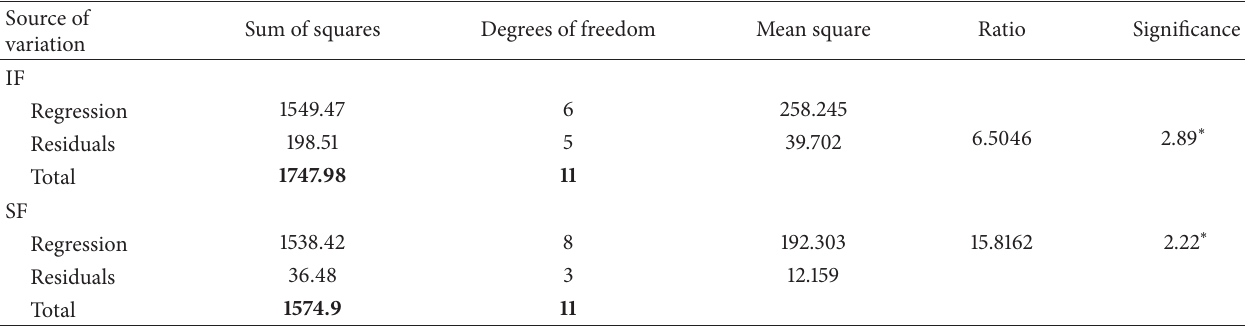
Table 6: Analysis of variance for Plackett-Burman designs.